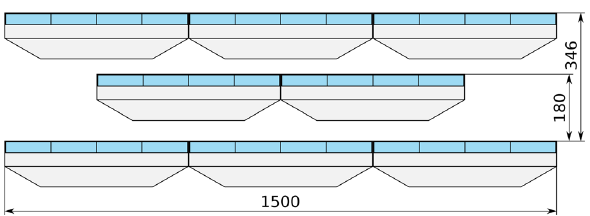
Fig. 3 Schematic view of the Muon Monitor. It consisted of 22 SC16 units. Each SC16 has 16 individual scintillator pixels, rendered in blue. The case of SC16 is outlined in grey. The dimensions are in